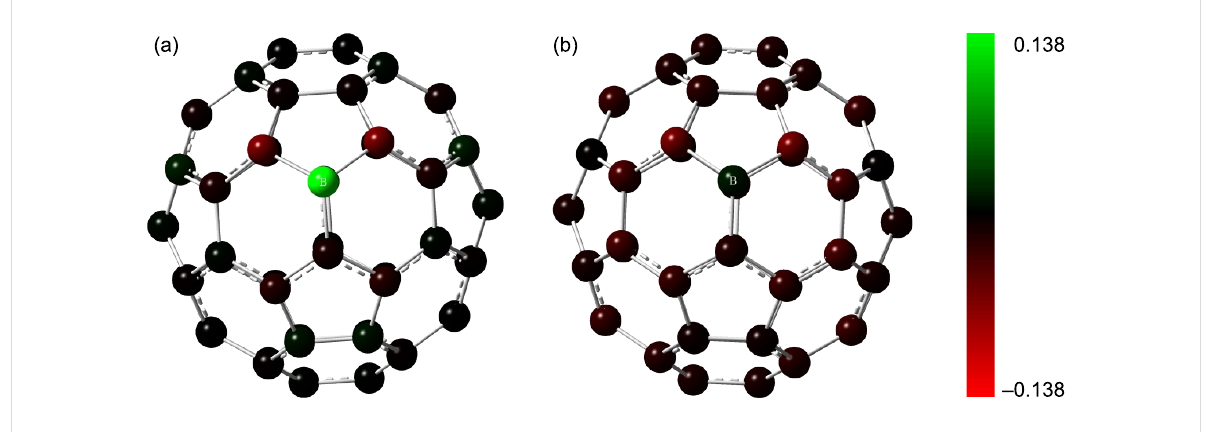
Figure 4: Mulliken charge distribution of (a) neutral BC 59 and (b) 1 e − -BC 59 . The atoms are shaded based on the charge distribution on each atom. The comparison suggests that the most notable charge transfer is on the B atom.